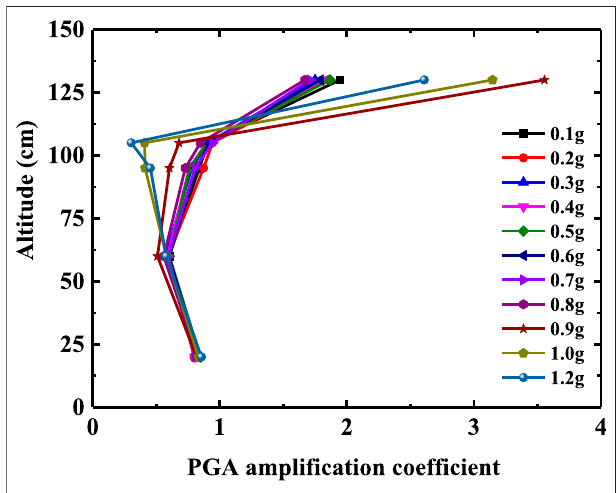
FIGURE 7 | PGA ampli fi cation coef fi cient of slope body under different seismic wave amplitudes.